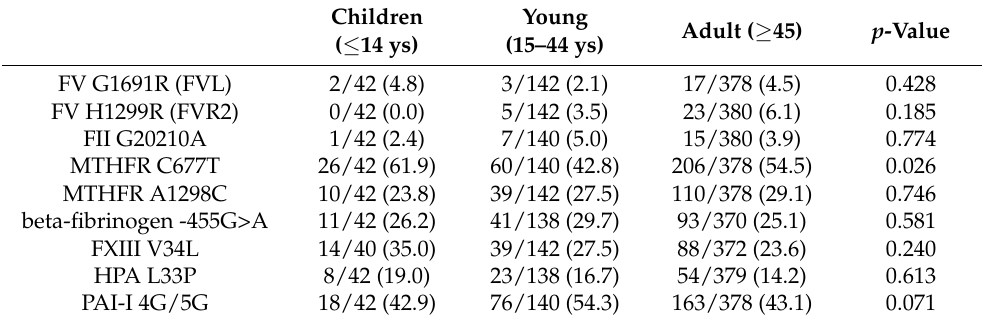
Table 5. Allele frequency, n and (%) of nine variants in different age groups with ischemic